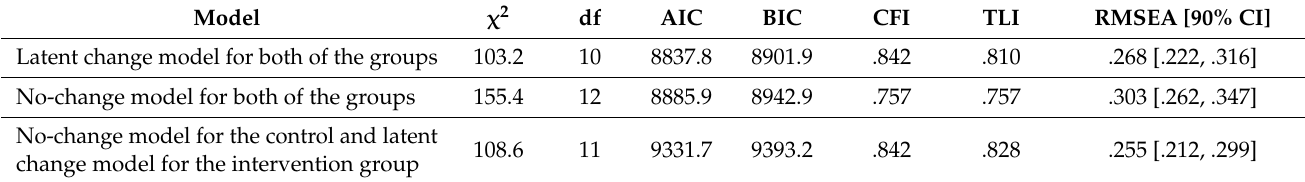
Table 6. Goodness-of-fit indices for the tested models on test level—between T1 and T2.